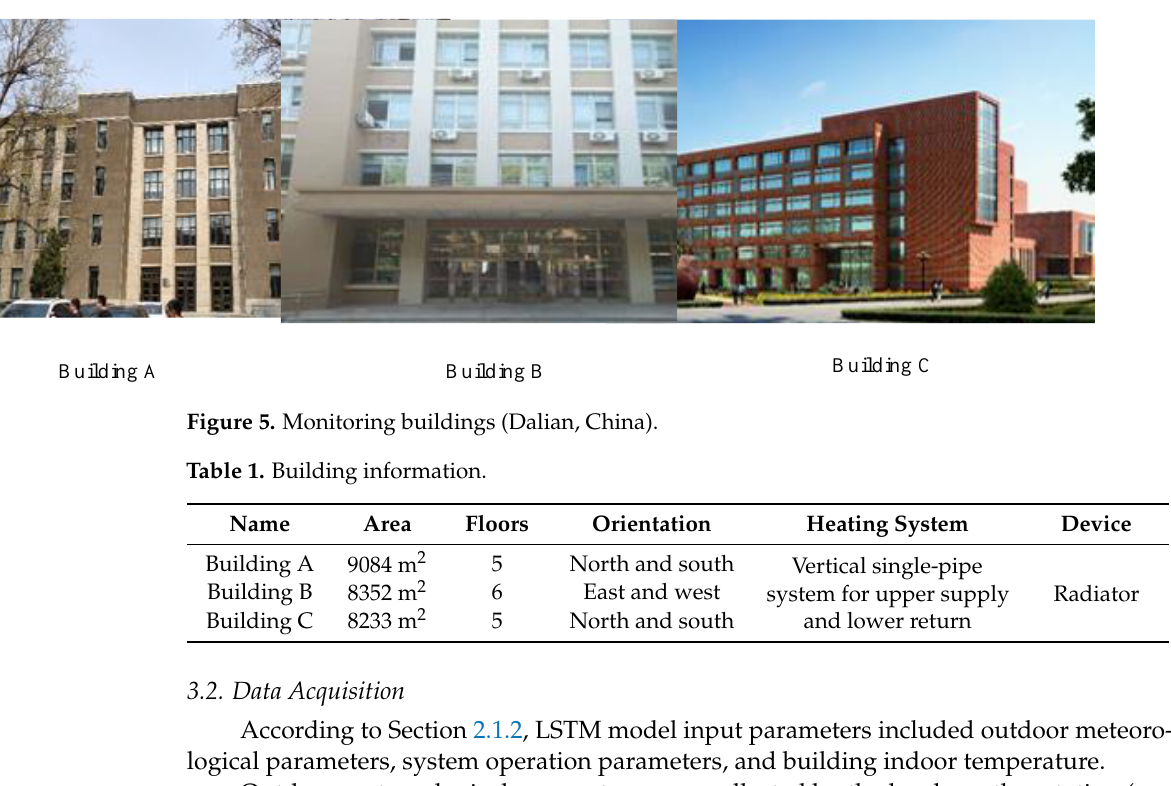
Figure 4. Flow chart of PSO algorithm.